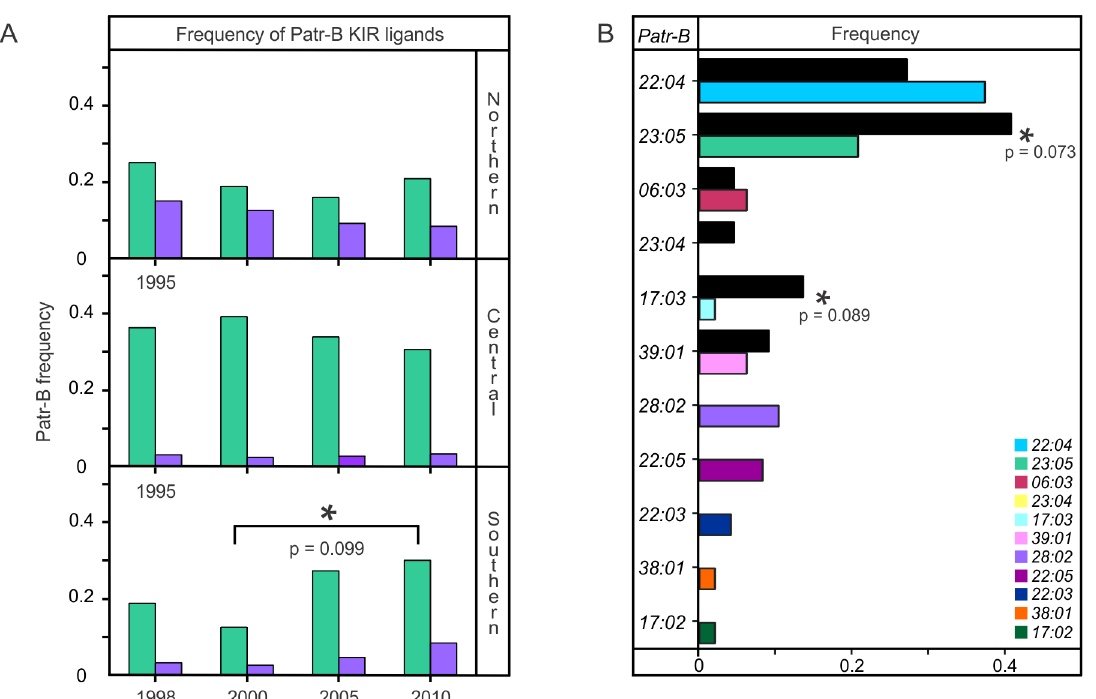
Fig 10. The frequency of the Bw4 KIR ligand is elevated among natal females and has increased in the southern community. (A) Patr-B * 23:05 is the only Gombe Patr-B allotype that carries the Bw4 epitope, a ligand for KIR receptors of NK cells. Similarly, Patr-B * 28:01 is the only Gombe Patr-B allotype that carries the C1 epitope, also a ligand for KIR. Shown are the temporal changes in the frequencies of Patr-B * 23:05 (green bars) and Patr-B * 28:01 (purple bars) in the three Gombe communities. In the northern and central communities, these frequencies were relatively stable, whereas in the southern community, there was a steady increase in the frequency of Bw4-bearing Patr-B * 23:05 during 2000 – 2010 when the southern community was declining (Fisher ’ s Exact test, p = 0.099). Although not significant, a monotonic increase in the frequency of C1-bearing Patr-B * 28:01 is also seen. The earliest census year was 1995 for the central and northern communities, and 1998 for the southern community. The community frequency data for these alleles are provided in S4 Data. (B) This compares Patr-B allele frequencies for natal (black bars) and immigrant (colored bars) female chimpanzees of the northern and central communities. The Patr-B * 23:05 and Patr-B * 17:03 alleles are enriched among natal females, but not immigrant females. Significance is denoted by asterisks (Fisher ’ s Exact tests, p -values are given beneath the asterisks). The frequency data are provided in S6